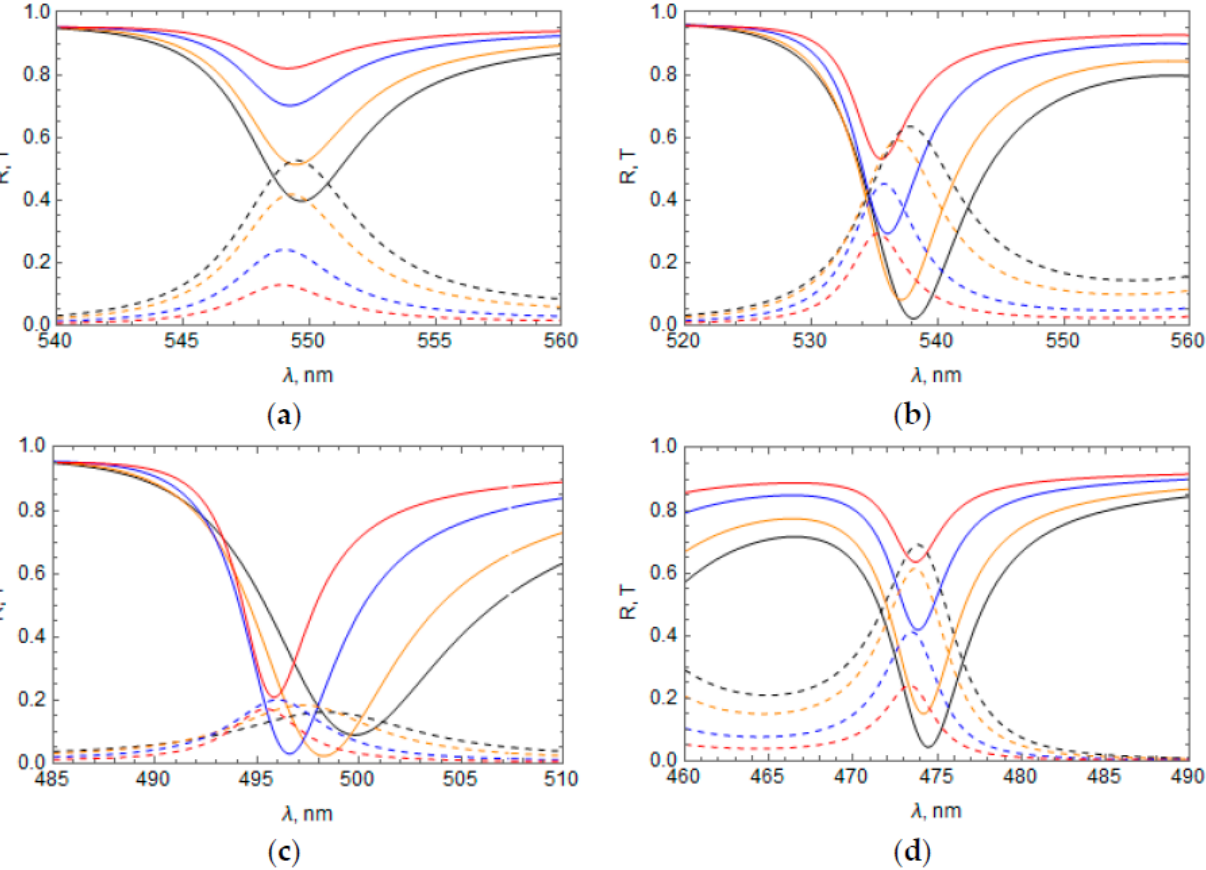
Figure 3. Influence of the Ag film thickness l on the reflectance and transmittance of the system for different RF pro- files n ( z ); ( a ) TPP band 1, n ( z ) = n − n p cos ( 2 π z / a ) ; ( b ) TPP band 2, n ( z ) = n + n p sin ( 2 π z / a ) ; ( c ) TPP band 3, n ( z ) = n + n p cos ( 2 π z / a ) ; ( d ) TPP band 4, n ( z ) = n − n p sin ( 2 π z / a ) . Reflectance—Solid lines, transmittance—Dashed lines, l = 30 nm—Black, 35 nm—Orange, 45 nm—Blue, 55 nm—Red. The TPP bands refer to those found in Figure